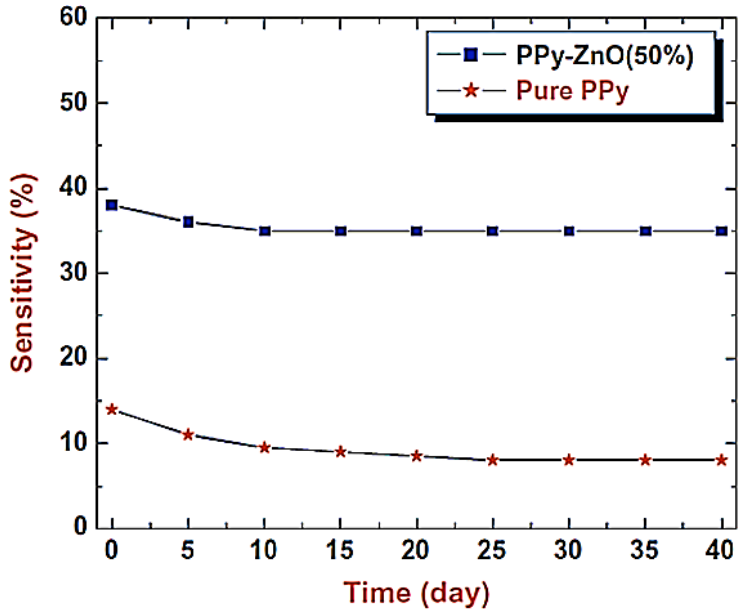
Figure 8. Sensitivity of neat polypyrrole (PPy) and polypyrrole/zinc oxide (PPy-ZnO) (50%) sensors [162]. Reproduced with permission from Elsevier.